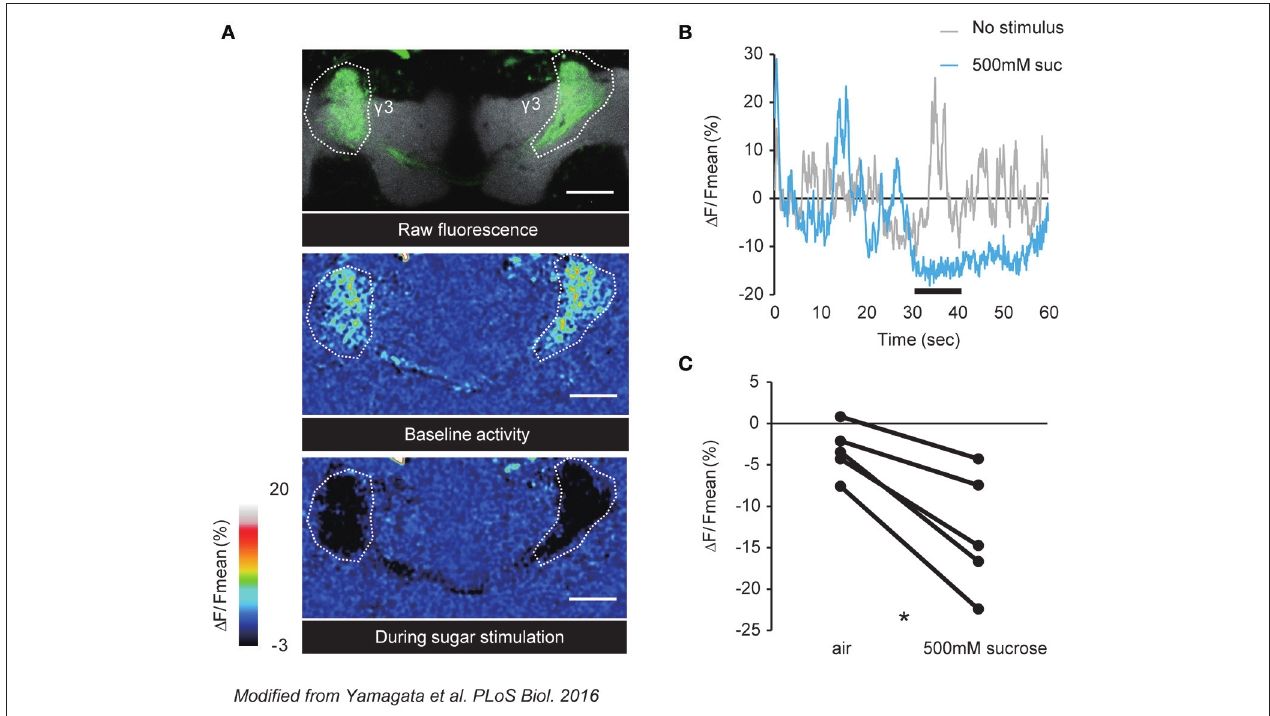
FIGURE 2 | Sucrose reward suppresses the spontaneous activity of PAM- γ 3. (A) Representative images of raw fluorescence of GCaMP expressed in the PAM- γ 3 DANs (top), baseline activity (middle), and calcium responses to sucrose stimulation (bottom). (B) Time course of the fluorescence signal. The black bar represents the sucrose presentation. Spontaneous DAN activity is suppressed by the sucrose presentation. (C) Average calcium responses to sucrose presentation. Sucrose intake significantly reduces the activity level of PAM- γ 3. Modified from Yamagata et al.